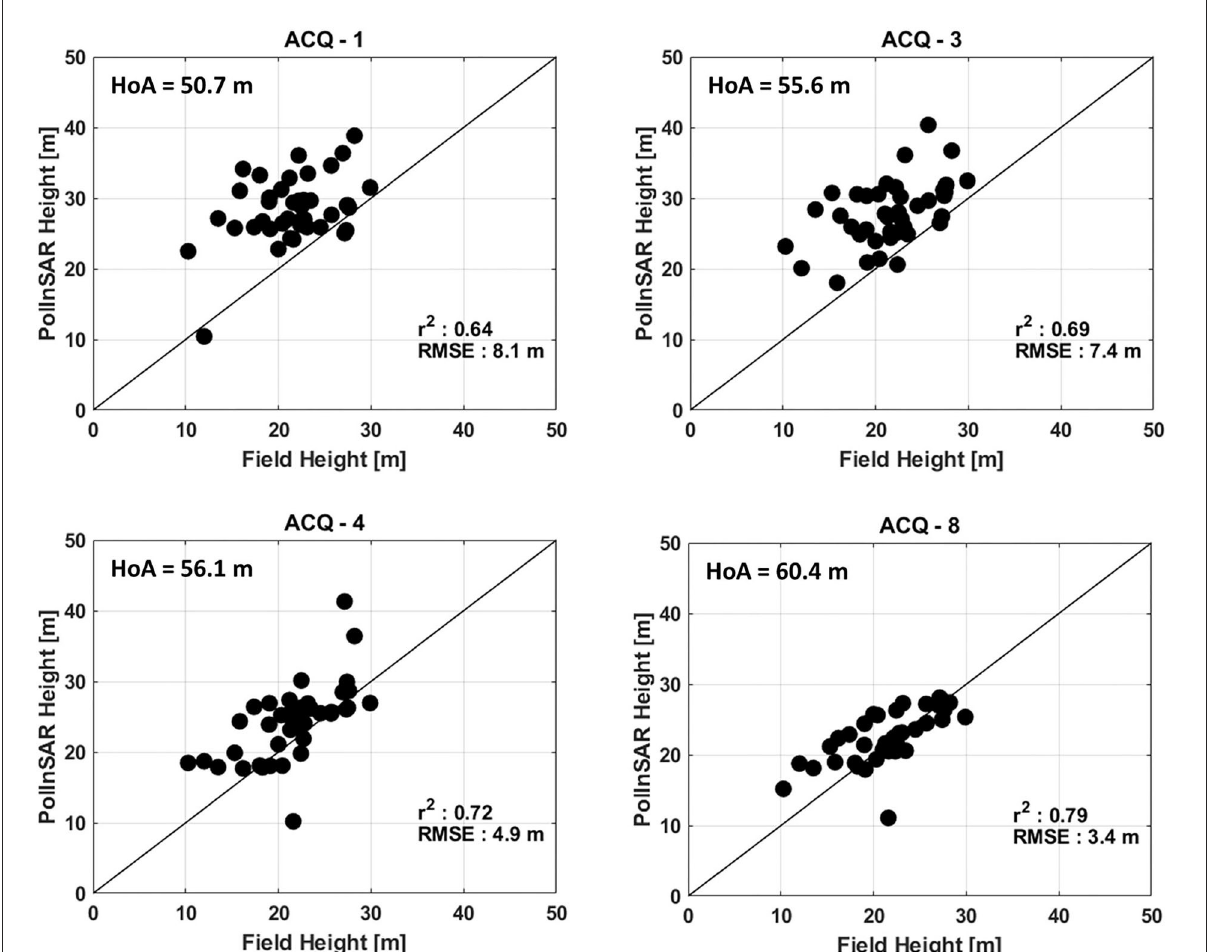
FIGURE5 Scatter plot describing the correlation between TDX interferometric height and reference height for validation. The correlation of height estimates with field retrieved height improves substantially with an increase in height of